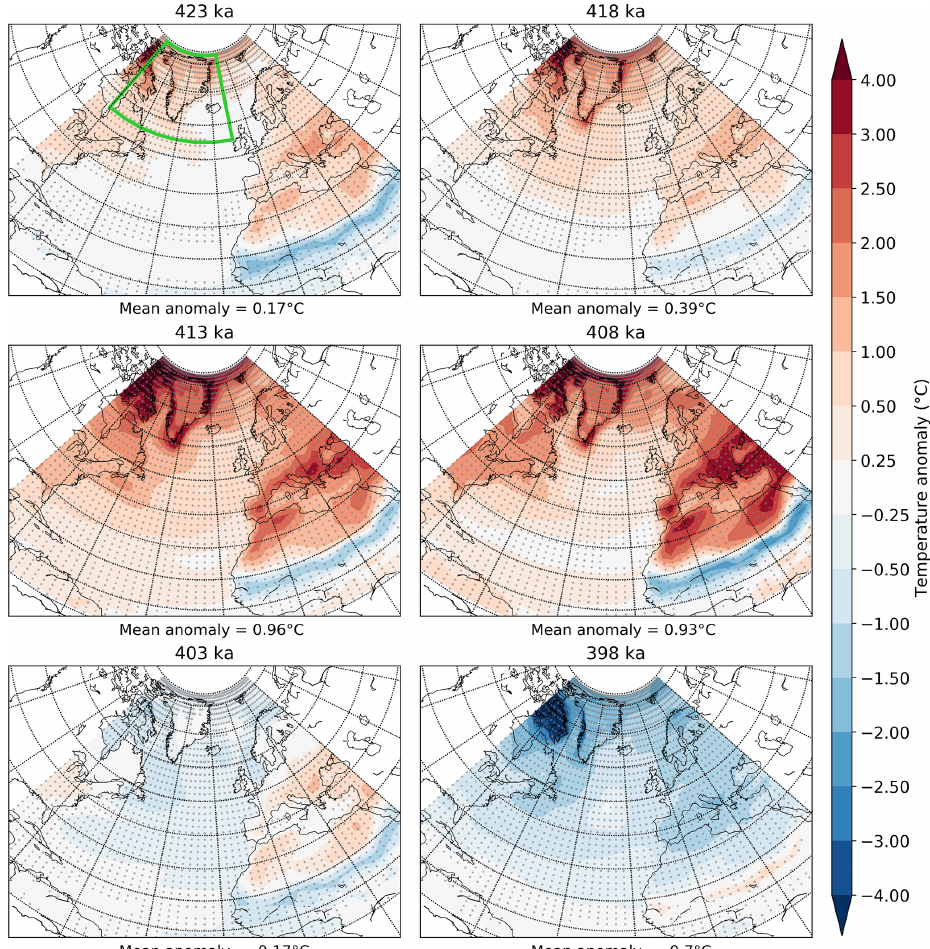
Figure 2. Mean JJA 2m temperature anomalies for the final 100 years of each CESM simulation corresponding to the listed time slices. Regions with stippling pass Student’s t test at the 95% significance level. The green box in the 423ka panel indicates the averaging region for the mean temperature values used in Fig. 1 and in the correlation plots (Figs. 4 and 7), 55–85 ◦ N and 280–350 ◦ E. The mean anomaly value listed beneath each panel is a cosine-weighted mean value of the complete shaded area (0–87 ◦ N, 270–40 ◦